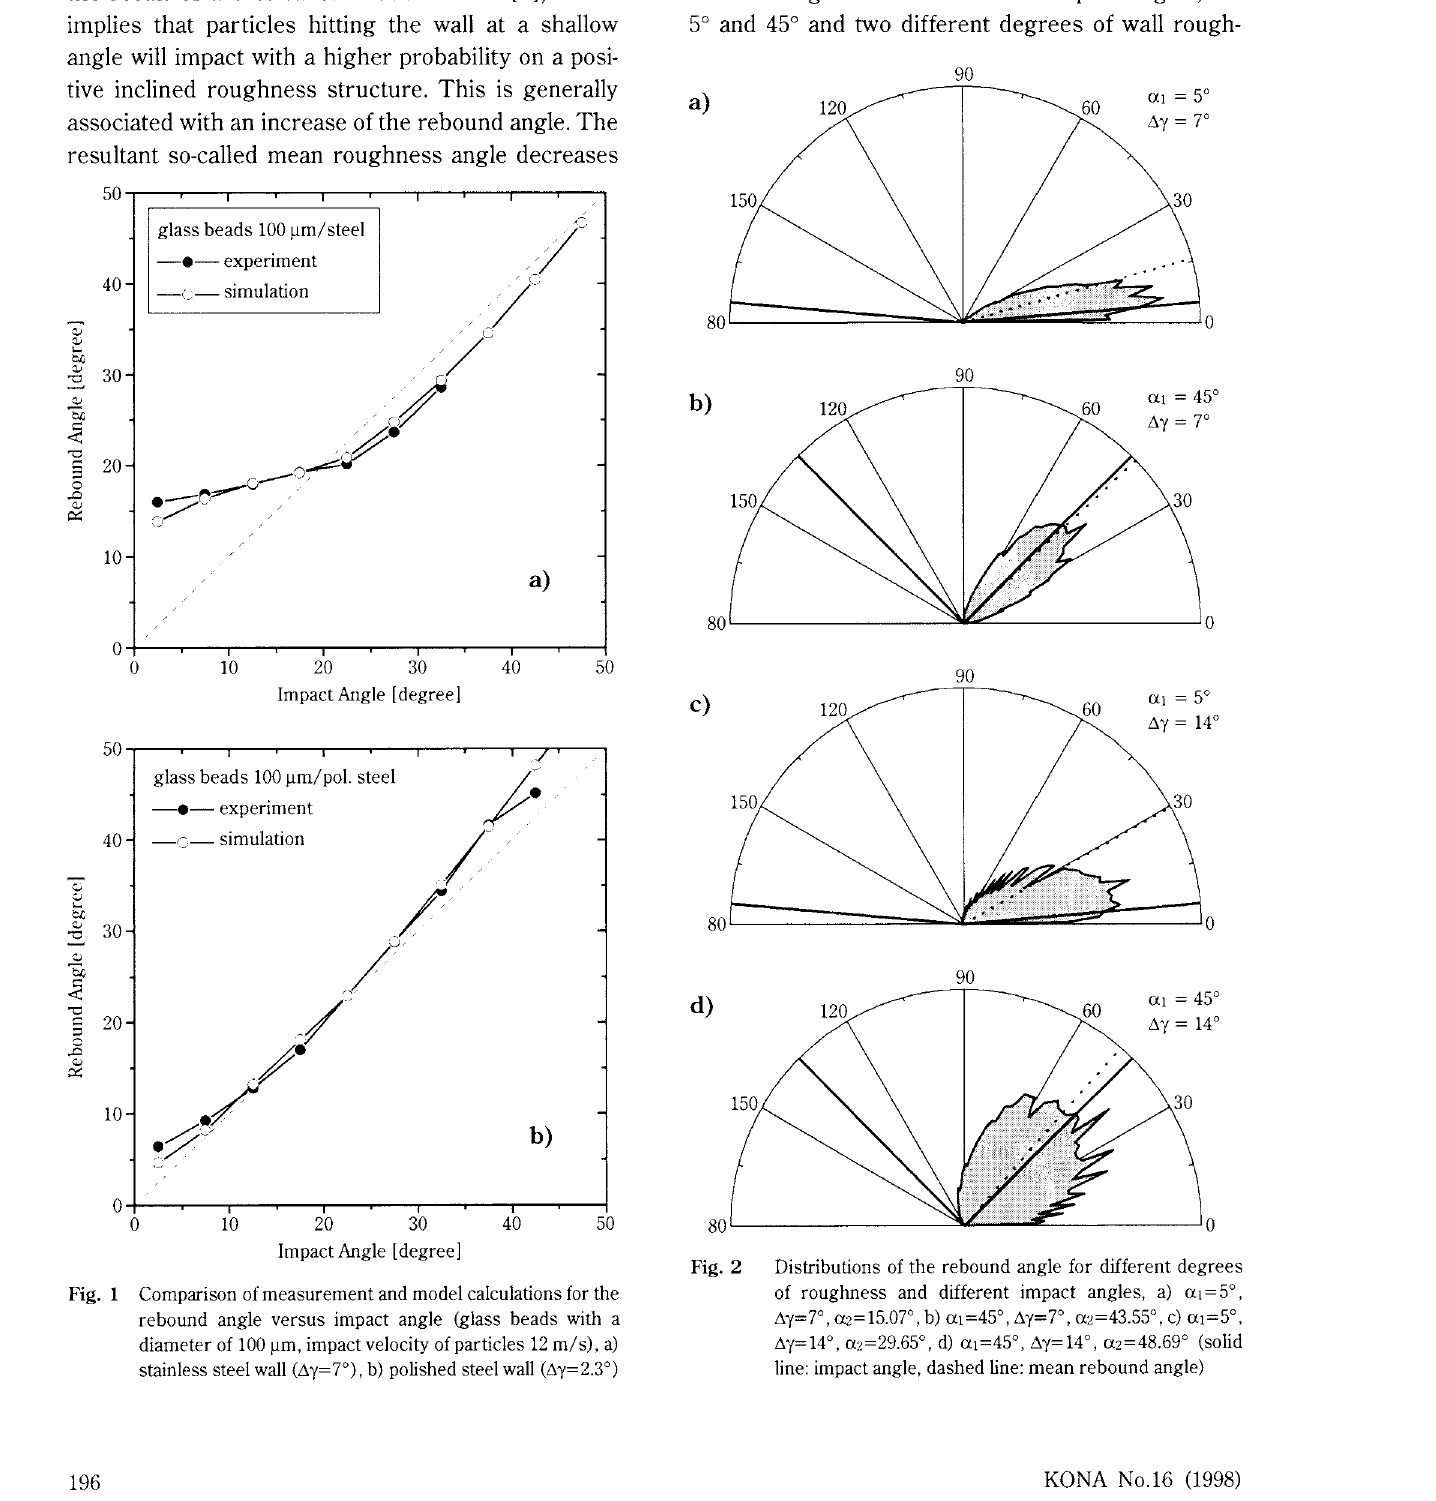
Fig. 1 Comparison of measurement and model calculations for the rebound angle versus impact angle (glass beads with a diameter of 100 11m, impact velocity of particles 12 m/s). a) stainless steel wall (l':.y=7°), b) polished steel wall (l':.y=2.3°)